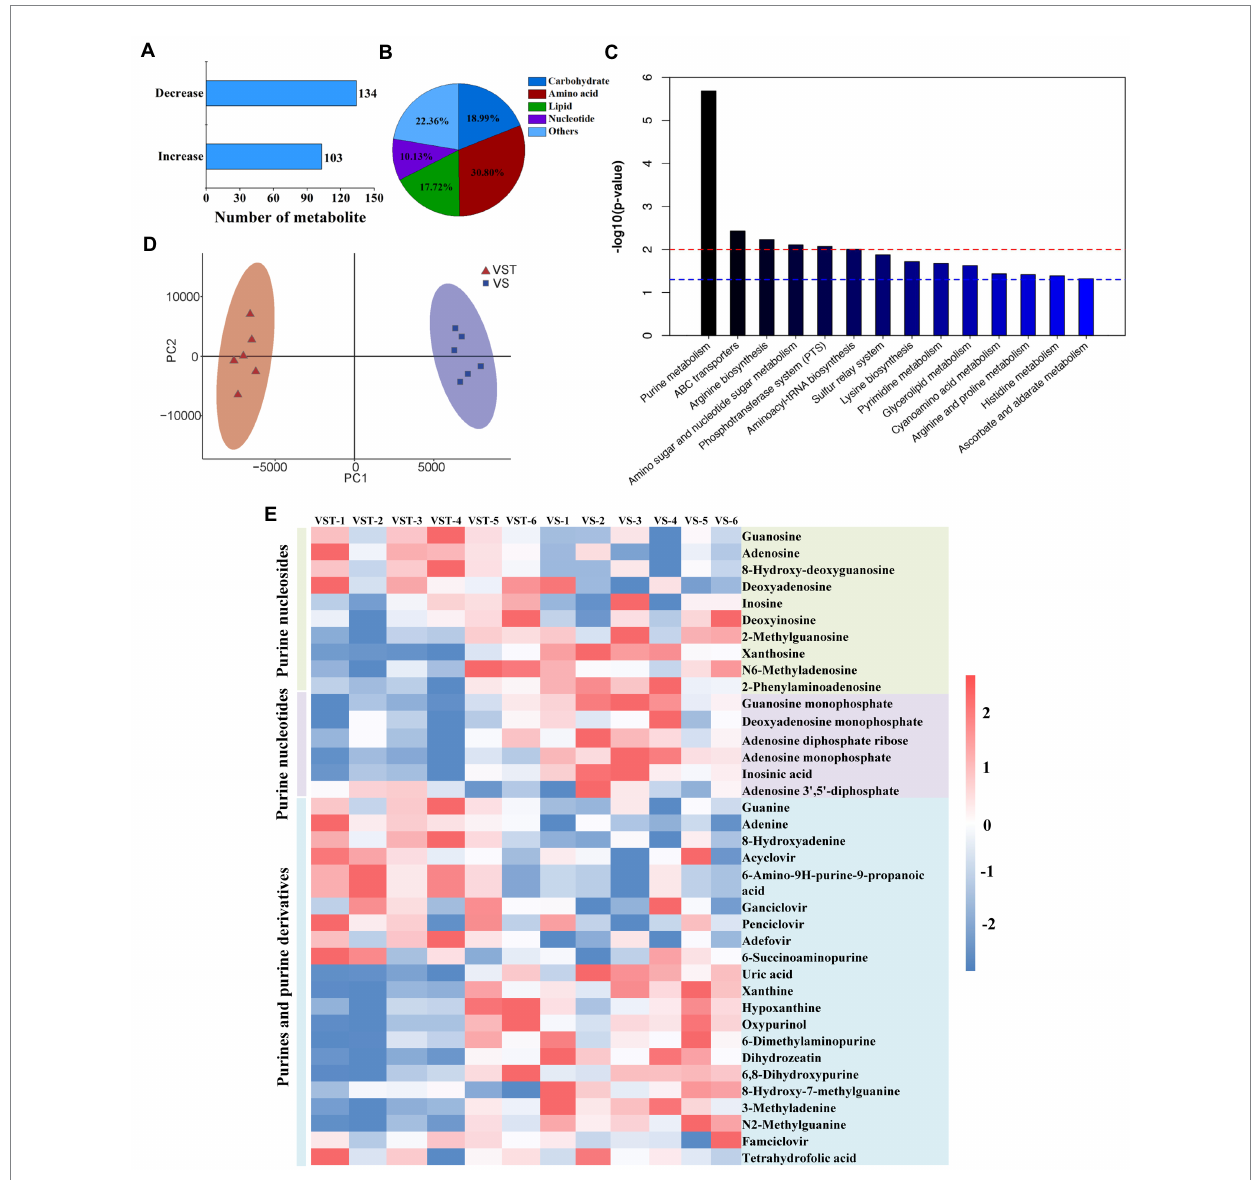
FIGURE 1 Metabonome analysis of tetracycline-induced persister cells (VST) and active cells ( VS ). The number of the differential metabolites were analyzed by LC–MS (A) , and the abundance of metabolic products were clustered into five categories (B) . PCA score plot analysis revealed that there was a distinction between VST group of red and VS group of purple (C) . The pathway of differential metabolite enrichment was indicated by KEGG analysis ( p < 0.05) (D) . (E) Heat map for relative abundances of purine metabolites in VST compared with VS. Red and blue indicated increased and decreased metabolite levels relative to the median metabolite level, respectively (see the color